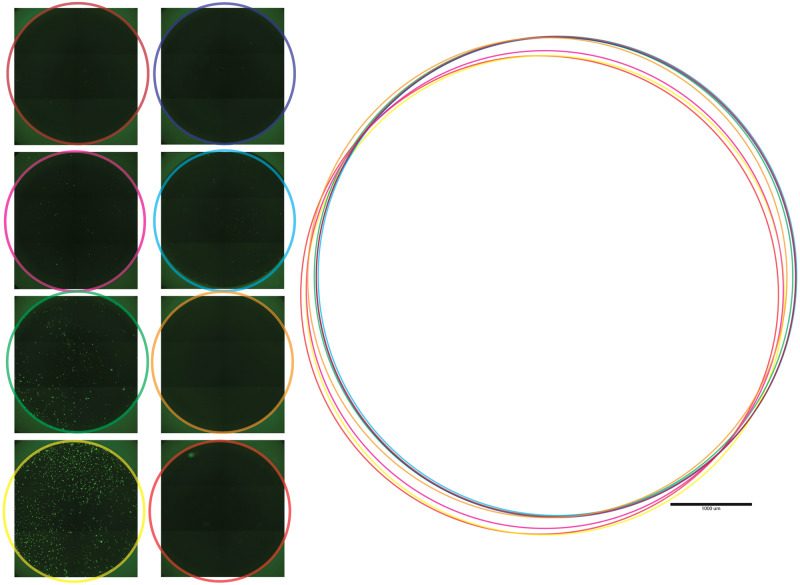
Well location variability.Comparing well A1 from eight 96-well plates shows the variability of the well location in the respective images. The growth area of each well is indicated by the color outlines (left). When these are overlaid, the variability is evident (right).